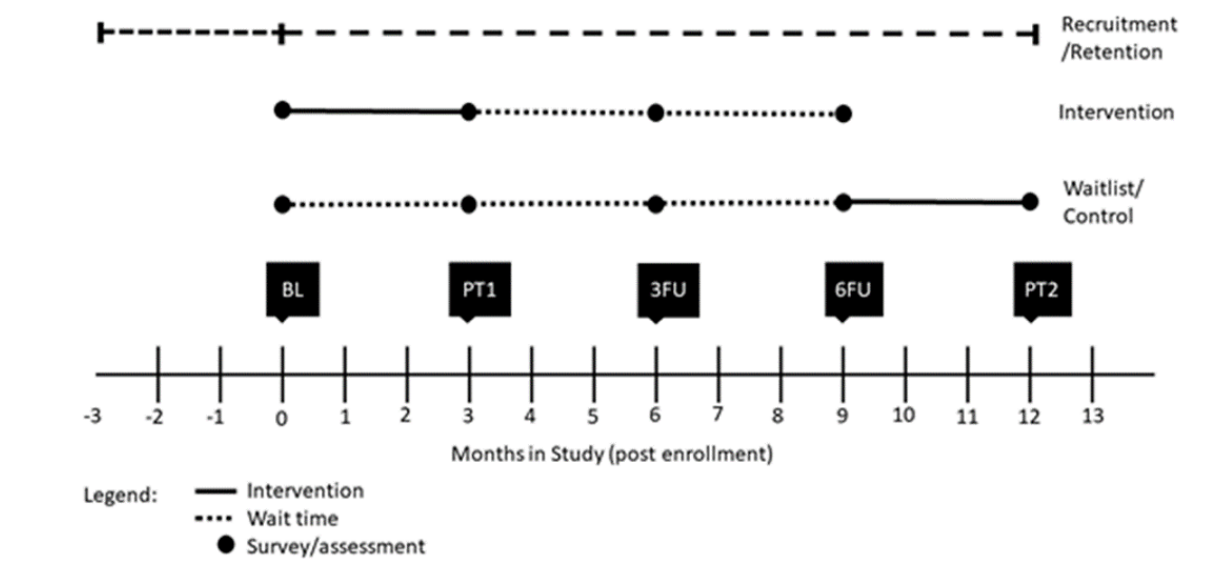
Figure 1. Timeline of participant activities and assessments. Only participants from the waitlist/control group who opt to participate in the intervention will be assessed in PT2. BL: baseline survey; PT: postintervention assessment; FU: follow-up